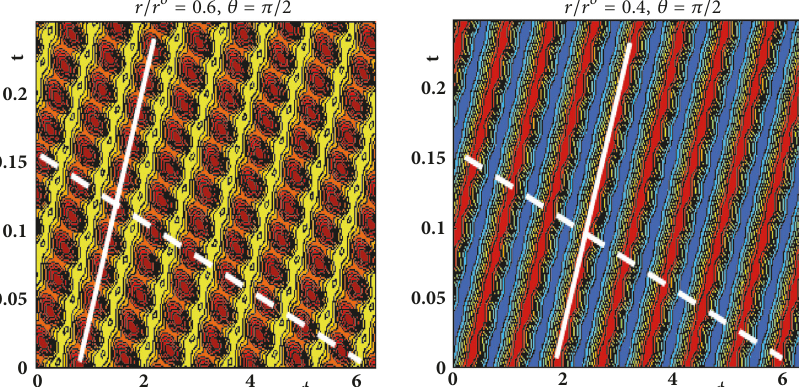
Figure 18: The quasi-periodic TW for 𝑅 = 1.1 ⋅ 10 6 : color maps of Θ along the azimuthal coordinate at the indicated equatorial circles.